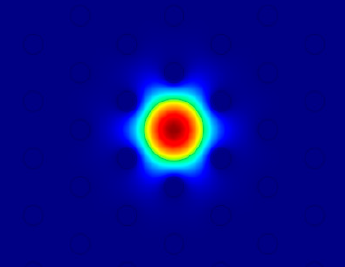
Figure 3. Norm of the electromagnetic field distribution of the M 1 mode guided in the core at the pump wavelength.